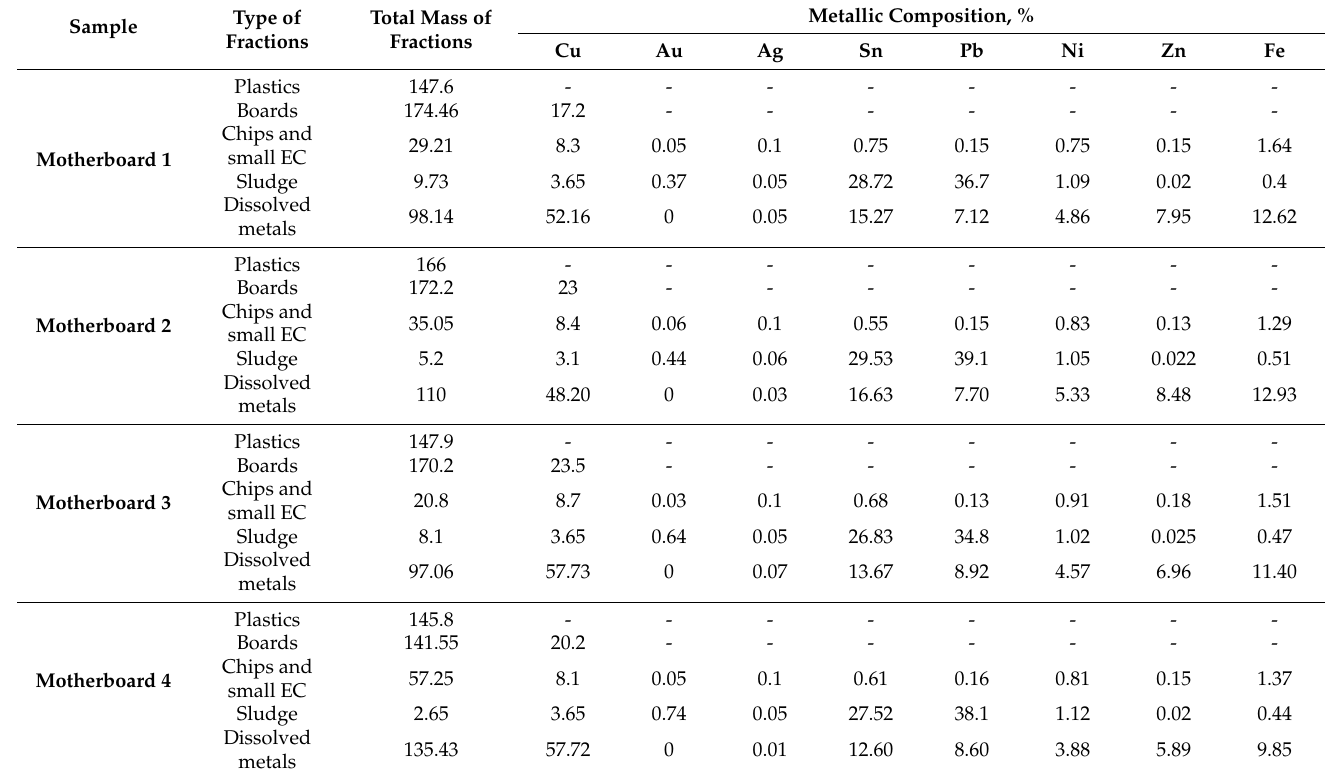
Table 7. The metallic composition of the different fractions obtained in the dismantling process.